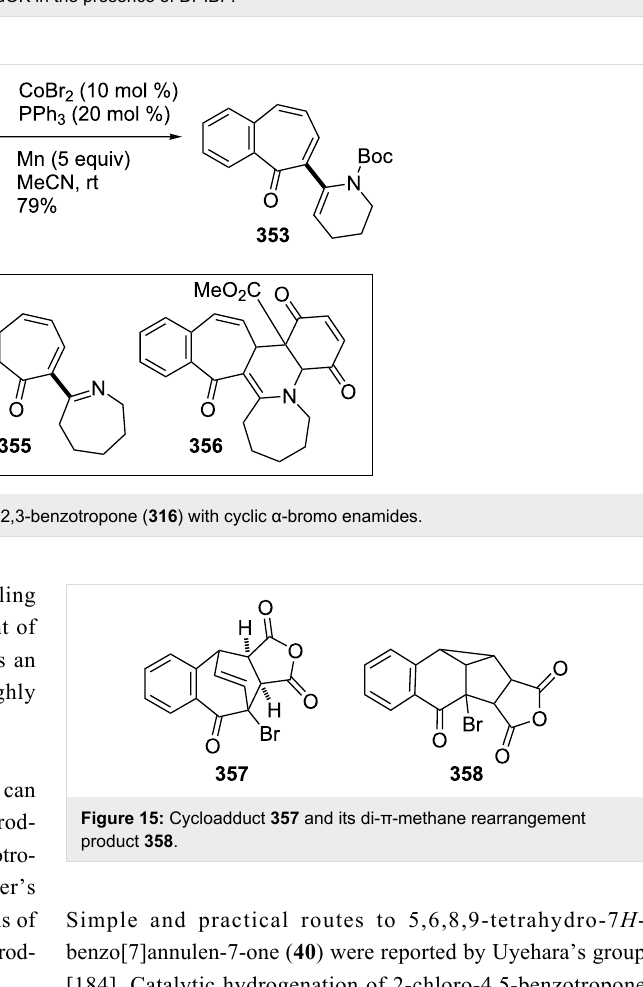
Simple and practical routes to 5,6,8,9-tetrahydro-7 H - benzo[7]annulen-7-one ( 40 ) were reported by Uyehara’s group [184]. Catalytic hydrogenation of